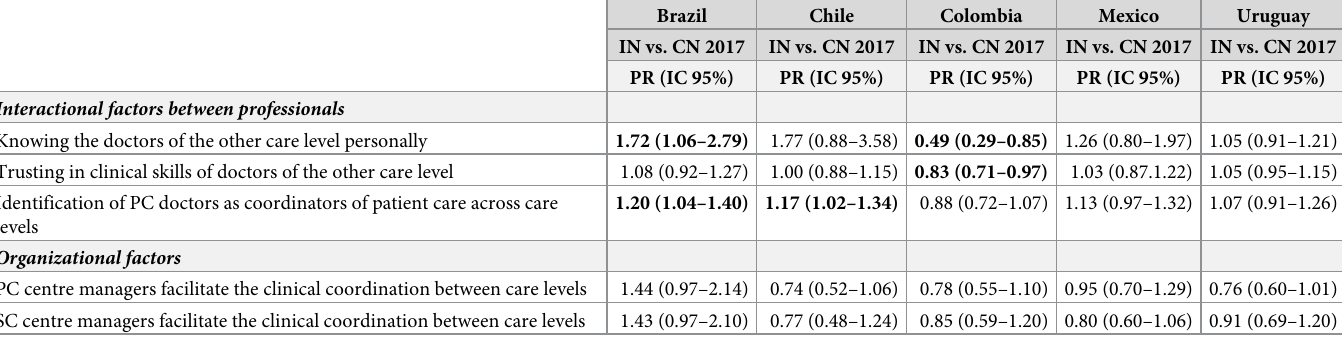
Table 4. Differences in influencing factors of cross-level clinical coordination (intermediate outcomes) in 2017 in the intervention and control networks of each country.